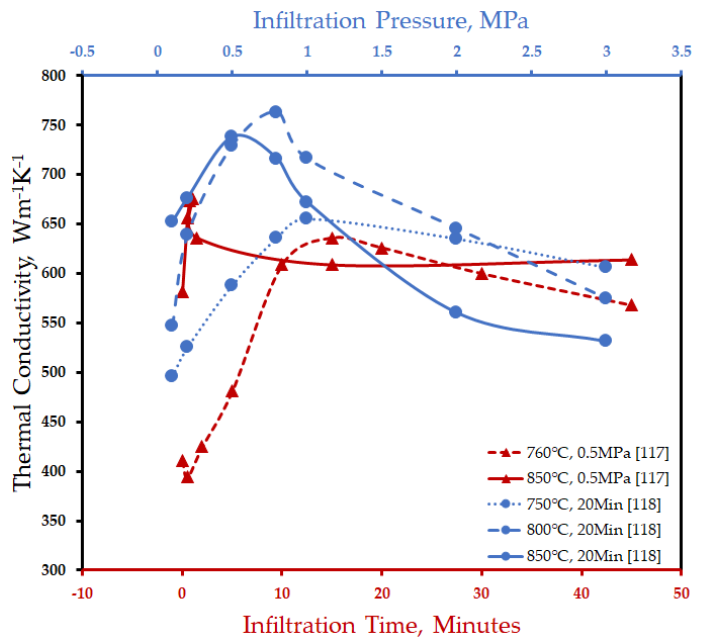
Figure 7. Effect of the infiltration temperature, time, and pressure on the thermal conductivity of AMCs fabricated by GPI.